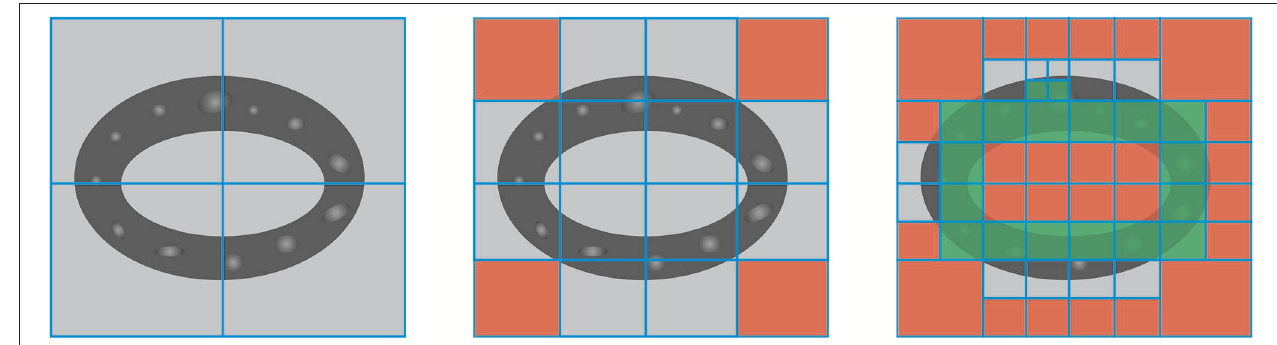
FIGURE 2 | Schematic representation of remeshing algorithm. Initial mesh (left). The first step of improving the mesh (middle), void elements highlighted with red. The second step of improving the mesh (right), elements suitable for calculation highlighted with green.